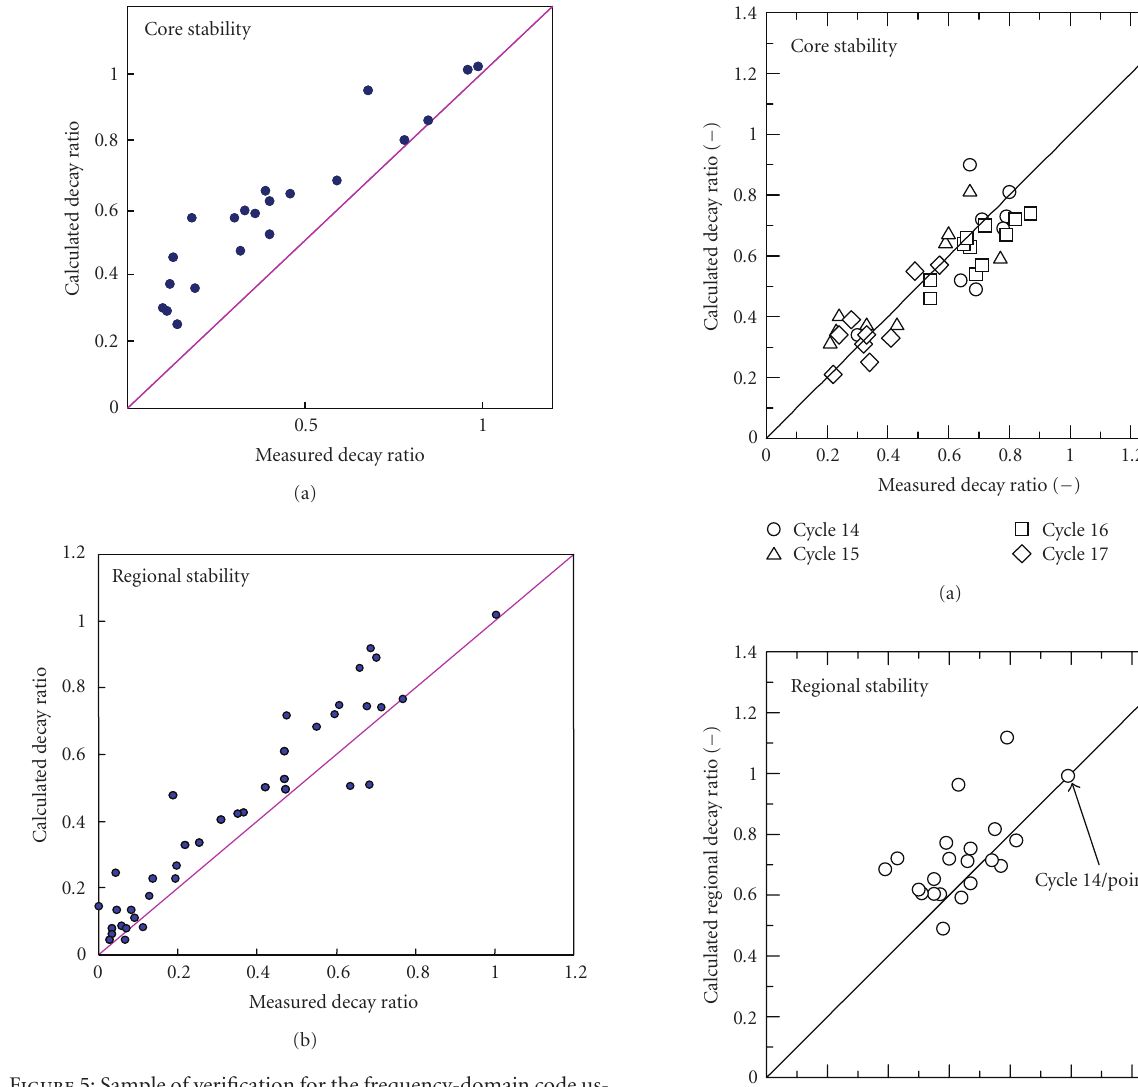
Figure 5: Sample of verification for the frequency-domain code us- ing stability test data.